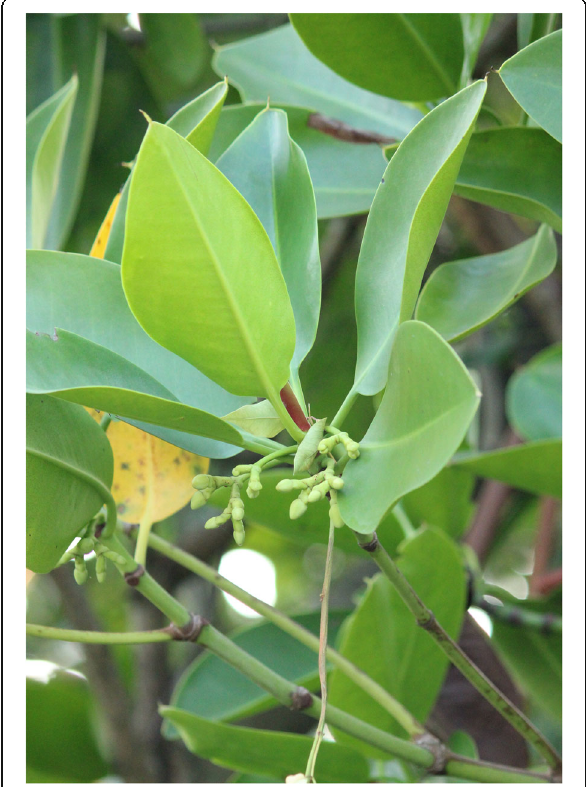
Fig. 1 Mangrove plant R. mucronata collected from Panangad swamp,